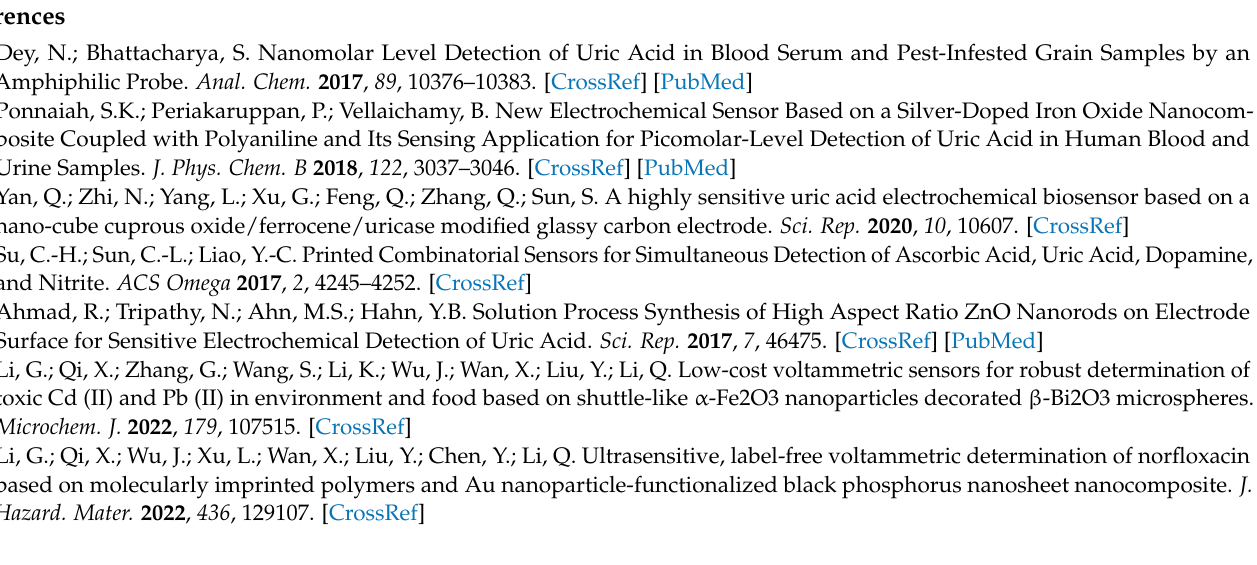
time; Figure S4: Bar chart of comparative study of different modified electrode; Figure S5: Diagram illustrates predicted interaction between mp20 with uric acid; Figure S6: Plot of CV curves of uric acid detection current versus potential; Figure S7: Graph of uric acid detection current versus number of electrode; Table S1: Table of central composite design (CCD) for the optimization of uric acid detection and the current response; Table S2: ANOVA table; Table S3: Table of constraints applied for the